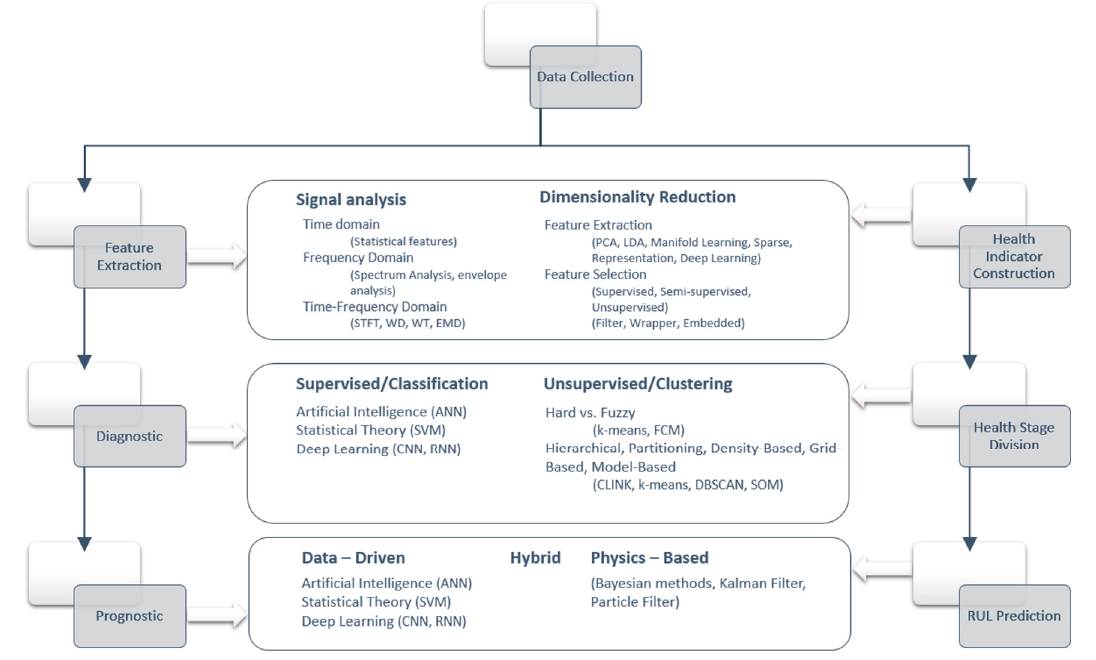
Figure 2. Existing functional architectures (application